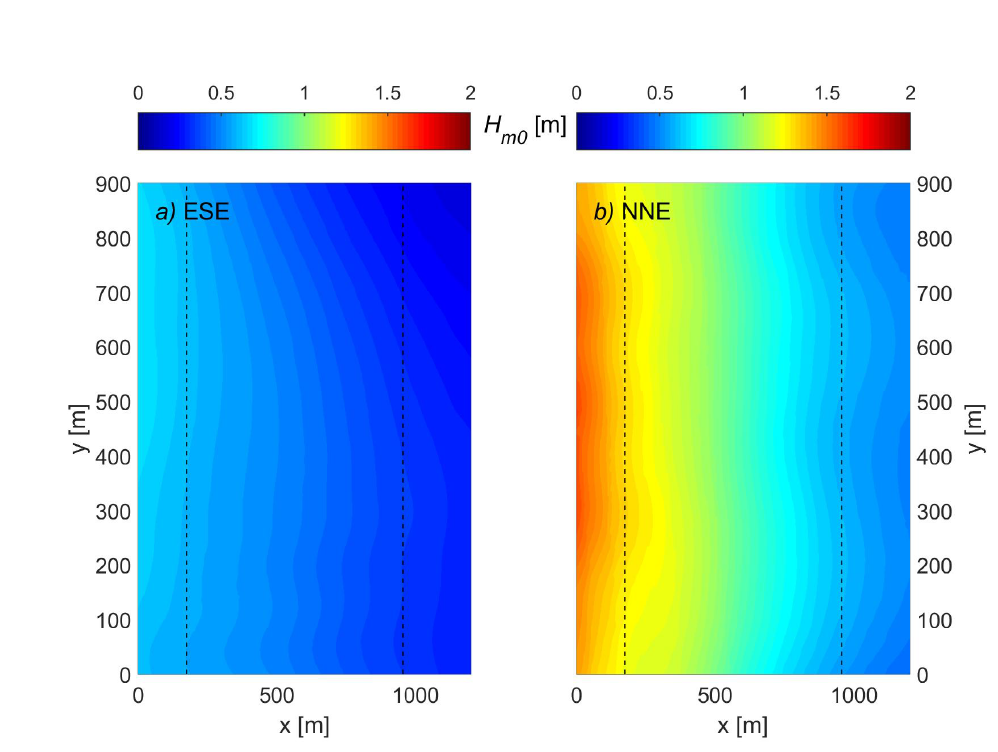
Figure 6. Reconstructed significant wave height: ( a ) ESE and ( b ) NNE simulations. Dashed lines indicate the locations at which the boundary conditions are chosen.